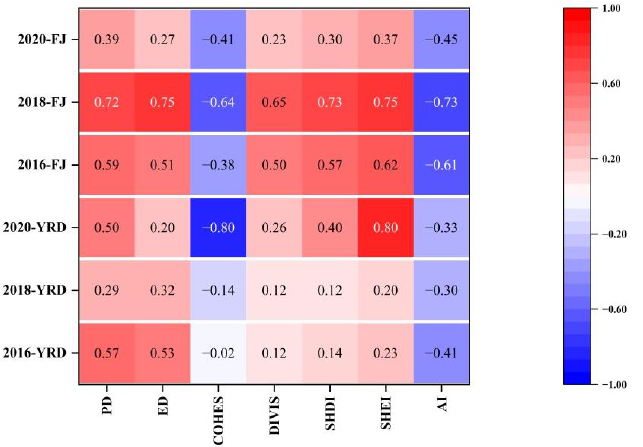
Figure 7. Correlation coefficients between annual mean PM 2.5 concentrations and landscape pattern index at overall level. index at overall